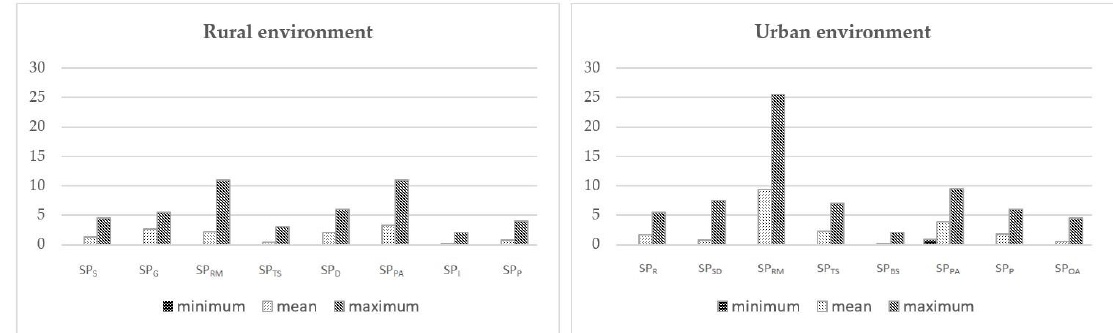
Figure 7. Minimum, maximum, and mean values obtained for each SP k (between all road sections “i”) for the rural and urban environments, respectively. Table 4. R 2 values for the rural environment.